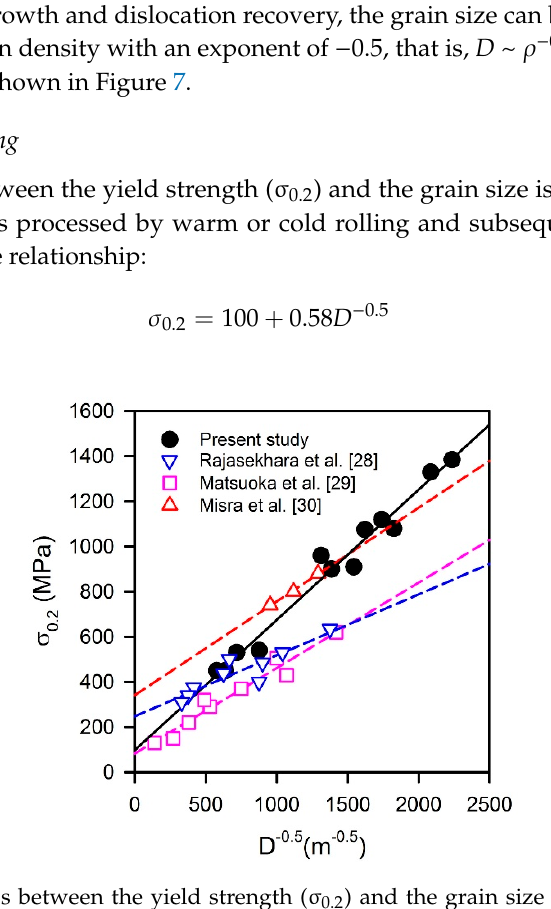
Figure 8. Relationships between the yield strength ( σ 0.2 ) and the grain size (D) in stainless steels processed by cold/warm working and annealing [28–30].